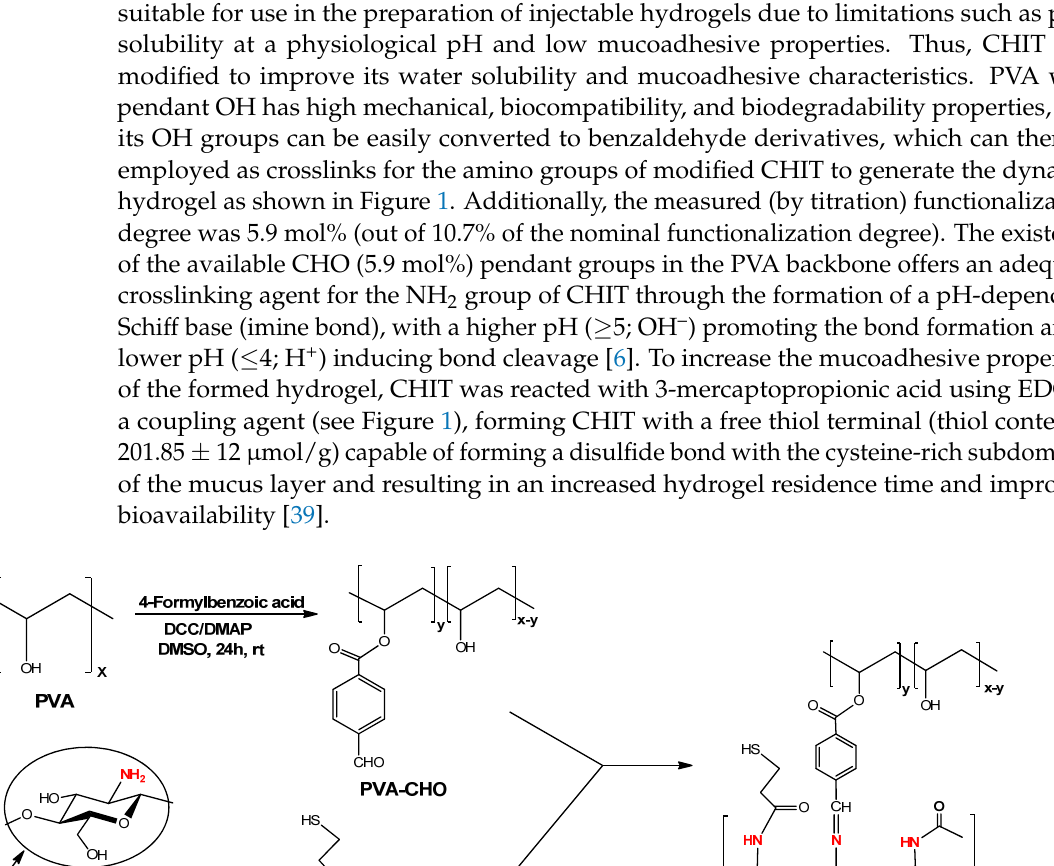
Figure 2. FTIR spectra of initial PVA, 4-formyl benzoate-PVA (PVA-CHO), initial CHIT, 3-mercap- topropionate CHIT (CHIT-SH), and PVA-CHO/CHIT-SH hydrogel. Furthermore, the successful substitution reaction was also confirmed with UV- ab- sorption spectroscopy by the appearance of the absorption band of a benzaldehyde moi- ety at a maximum wavelength λ max = 255 nm [44] (see Figure S1 in the Supplementary Materials). The main characteristic peaks of the initial chitosan (CHIT) were detected at 3440, 2890, 1670, 1565, 1430, 1380, 1160, 1080, and 1035 cm − 1 . These peaks were attributed to the stretching vibrations of the –OH and –NH 2 groups, C–H stretching vibration, C=O stretch- ing of the amide I band, bending vibrations of the N–H (N-acetylated residues, amide II band), C–H bending, O–H bending, antisymmetric stretching of the (C–O–C) bridge, and